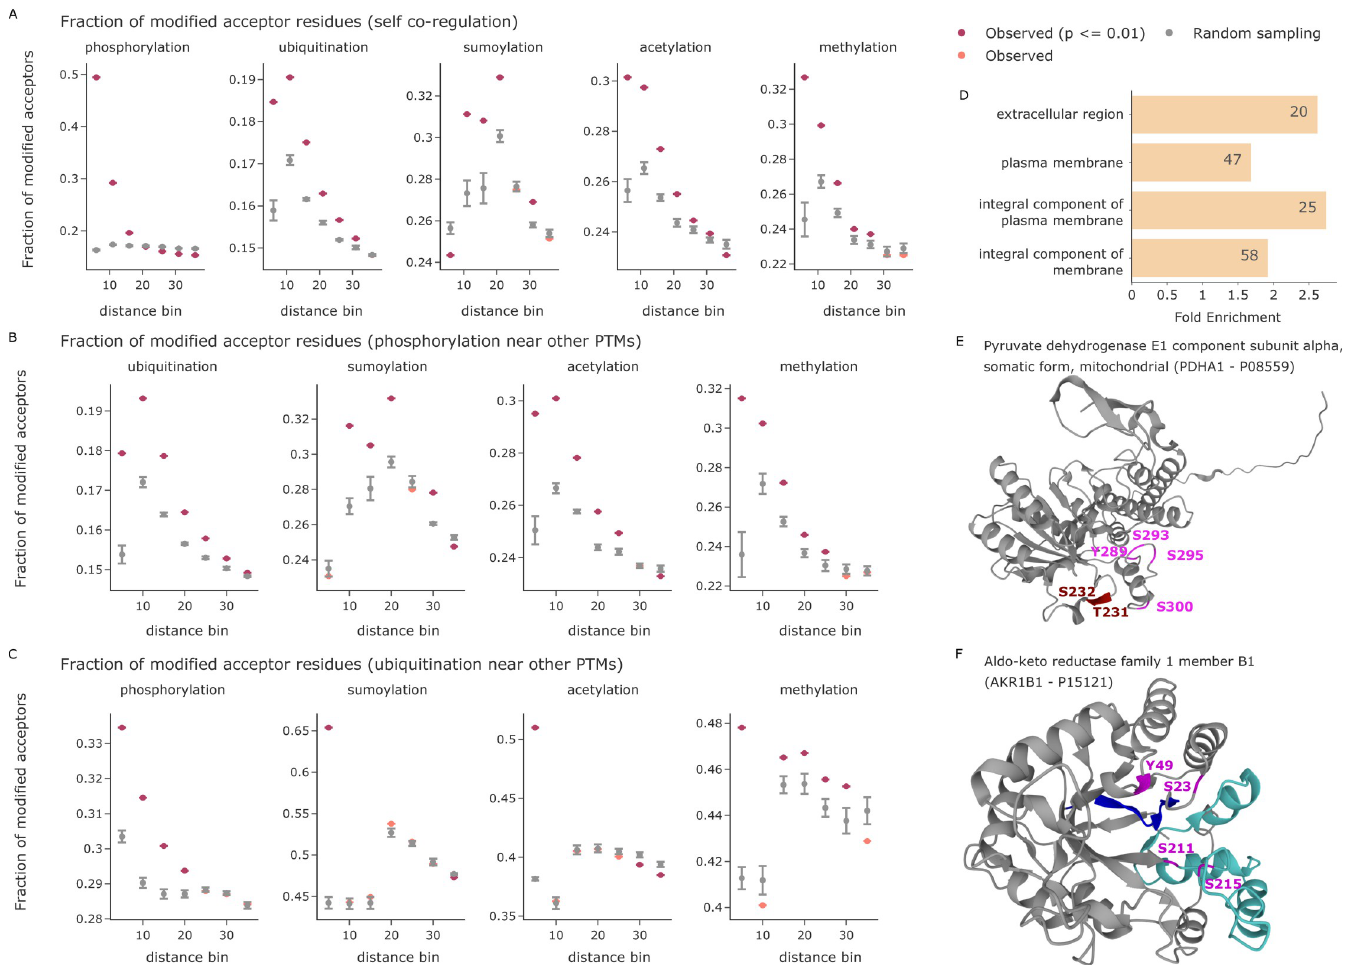
Fig 5. PTM proximity analysis in 3D. (A) The fraction of modified PTM acceptor residues is shown as a function of the 3D distance to a given modified amino acid in Å . Observed values (indicated in red when statistically significant and colored in salmon otherwise) are compared to the mean of 5 random samples including the same number of modified PTM sites (gray). Error bars indicate one standard deviation. The x-axes are divided in distance bins ranging from each previous bin to the indicated cutoff in Å . Source data are available at Github. (B) The fraction of modified phospho-acceptor residues is shown as function of the 3D distance to a given modified amino acid in Å . Source data are available at Github. (C) The fraction of ubiquitinated lysines is shown as function of the 3D distance to a given modified amino acid in Å . The smallest bin shows competition for the same central lysine residue. Source data are available at Github. (D) Enrichment analysis of proteins with 3D phospho- and/or ubiquitination clusters (FDR � 0.01). Source data are available at Github. (E) The predicted structure of PDHA1. Phosphorylations on the phospho-loop A are indicated in dark red (T231 and S232). The phosphorylations on phospho-loop B are indicated in magenta (Y289, S293, S295, and S300) [36]. (F) The predicted structure of AKR1B1. Residues annotated as NADP binding sites are highlighted in blue (amino acids 10 to 19) and turquoise (amino acids 211 to 273). Phosphorylations are indicated in magenta. AKR1B1, aldo-keto reductase family 1 member B1; PDHA1, pyruvate dehydrogenase E1 component subunit alpha; PTM, posttranslational modification.